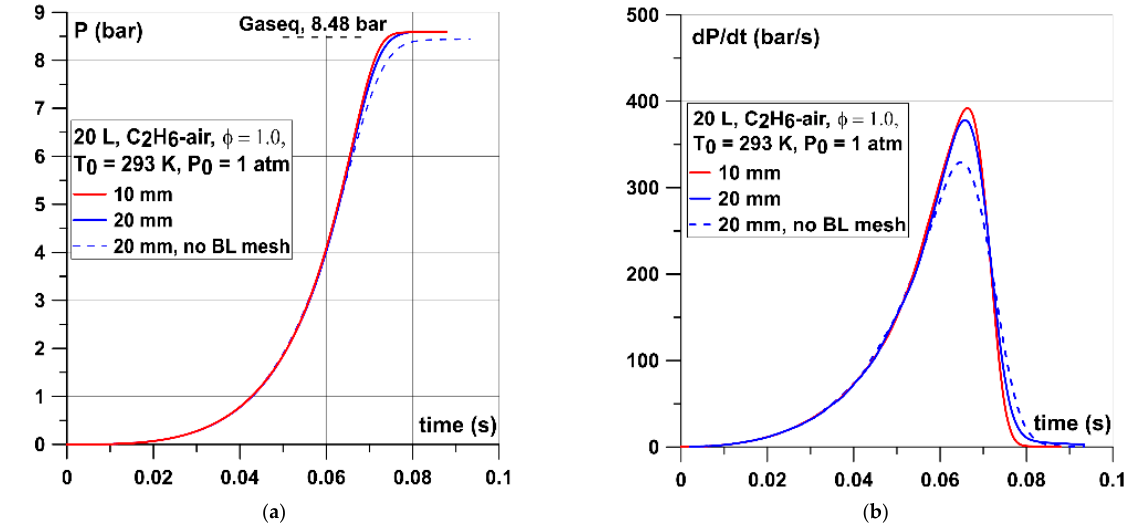
Figure 7. Influence of the mesh size and boundary layer mesh at wall on the: ( a ) pressure and ( b ) dP/dt traces for stoichiometric C 2 H 6 –air mixture at standard conditions. Gaseq line shows the theoretical pressure under constant volume combustion